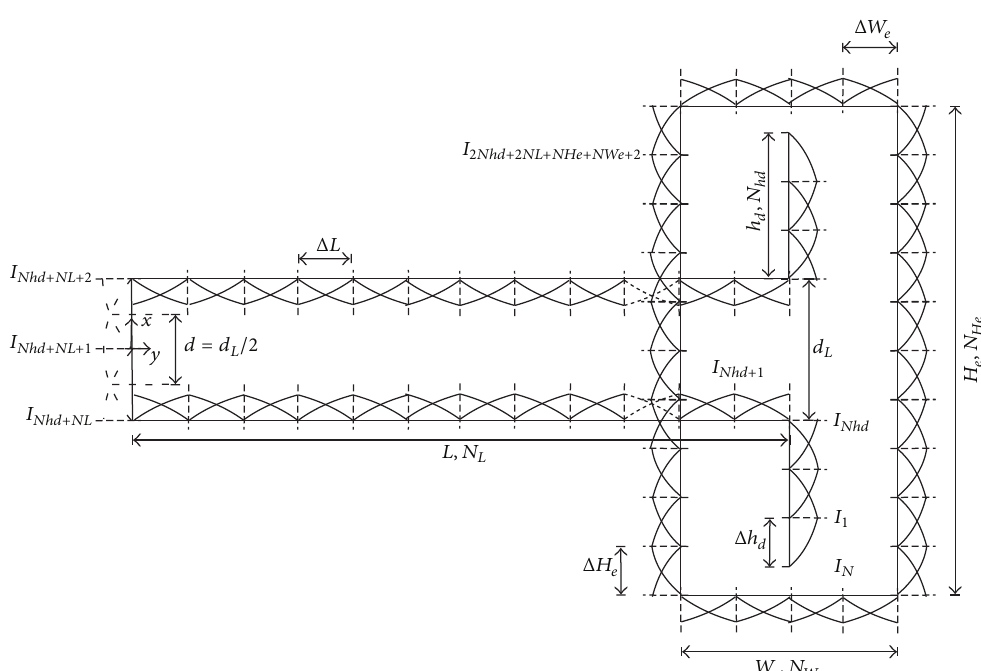
Figure 4: Discretization of nanocircuit, top view ( 𝑧 -axis) for application of MoM.